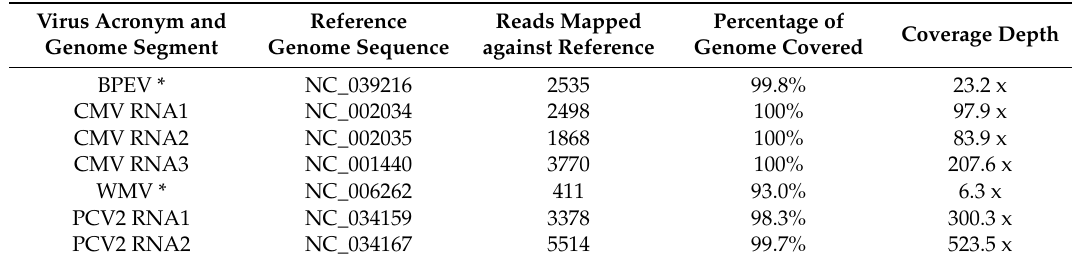
Figure 1. Phylogenetic tree generated on complete nucleotide genome sequences of bell pepper endornavirus (BPEV) isolates. The phylogenetic analysis was inferred using maximum likelihood (ML) based on the General Time Reversible (GTR) model selected as the best-fit model of nucleotide substitution based on Bayesian information criterion (BIC) as implemented in MEGA 7. Isolates are identified by their GenBank accession numbers and country of origin. The Slovak isolate N65 sequenced in the present study is highlighted in bold. Hot pepper endornavirus (HPEV) was used as an outgroup. The scale bar indicates a genetic distance of 0.1. Bootstrap values higher than 70% (1000 bootstrap resamplings) are indicated. Table 1. Virome of the pepper N65 HTS dataset as resulted by mapping of 5,511,704 high-quality reads with Geneious software.